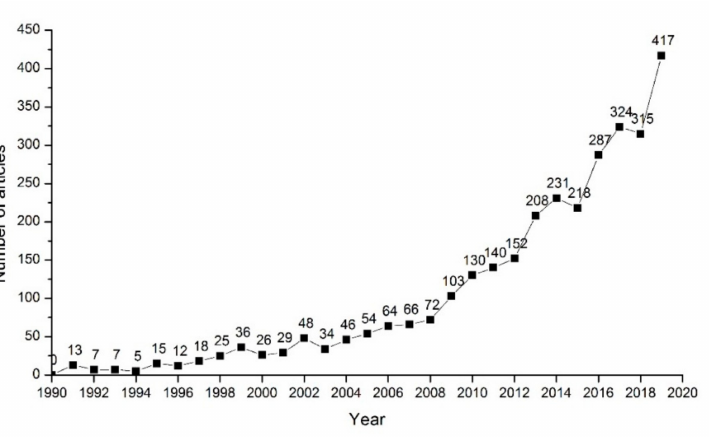
Figure 1. Annual trend of safety sign literature.